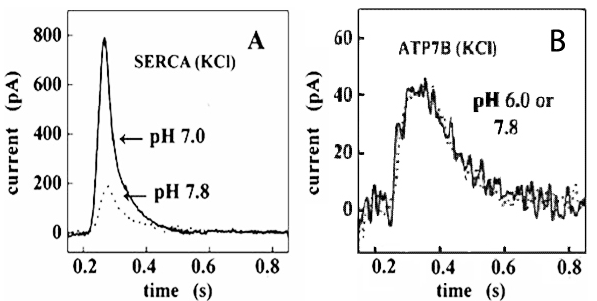
Figure 9. Charge measurements measured with enzymes absorbed on solid supports member (SSM). A: Current transients follow- ing addition of ATP to SERCA in a reaction mixture including 10 microM free Ca2+ and 100 mM KCl at pH 7.0 (solid line) or pH 7.8 (dotted lines). C: Current transients after addition to ATP on ATP7B in a reaction mixture containing 5 microM Cu + and 100 mM KCl at pH 6.0 (solid line) or 7.8 (dotted line). 28